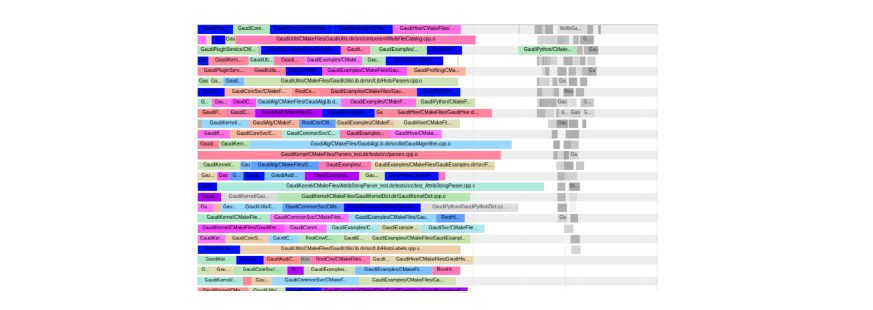
Figure 4. Profile of a distributed build of Gaudi extracted from the Ninja log and visualised with Chromium’s trace event profiling tool [8]. The horizontal axis denotes elapsed time and spans between 0 and 100 s. Each row represents one of the 100 Ninja jobs (only the first quarter is shown for brevity). Coloured boxes show remote compilation while grey denotes the execution of local build rules.